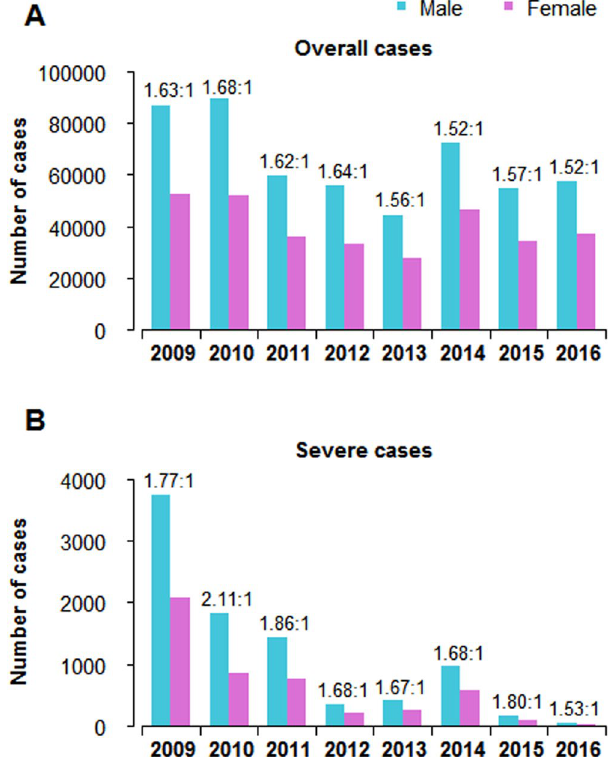
Figure 1. Sex distribution and clinical severity of overall cases of HFMD in Shandong province, 2009–2016. ( A ) Sex distribution of probable and laboratory-confirmed cases. ( B ) Sex distribution of severe